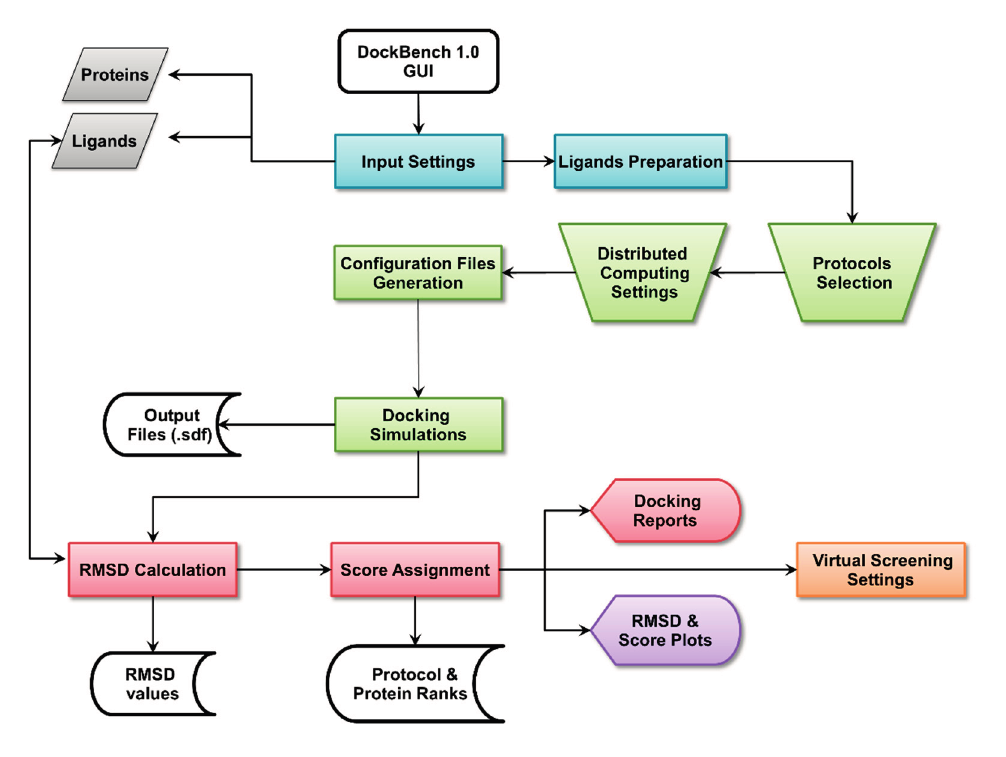
Figure 1. DockBech 1.0 workflow. The platform is accessed through a GUI, the different stages of the pipeline are highlighted with different